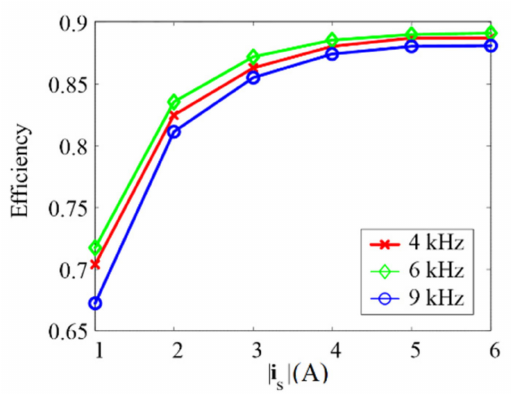
Figure 2. Measured e ffi ciency characteristics of the permanent magnet synchronous machine (PMSM) drive at di ff erent switching frequencies.